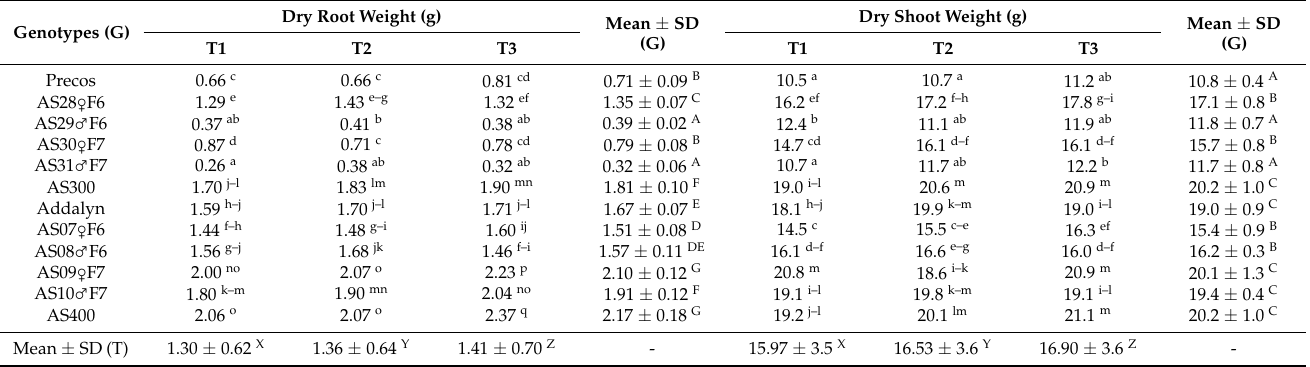
Table 4. Dry root weight and dry shoots weight of tomato plants according to genotype and